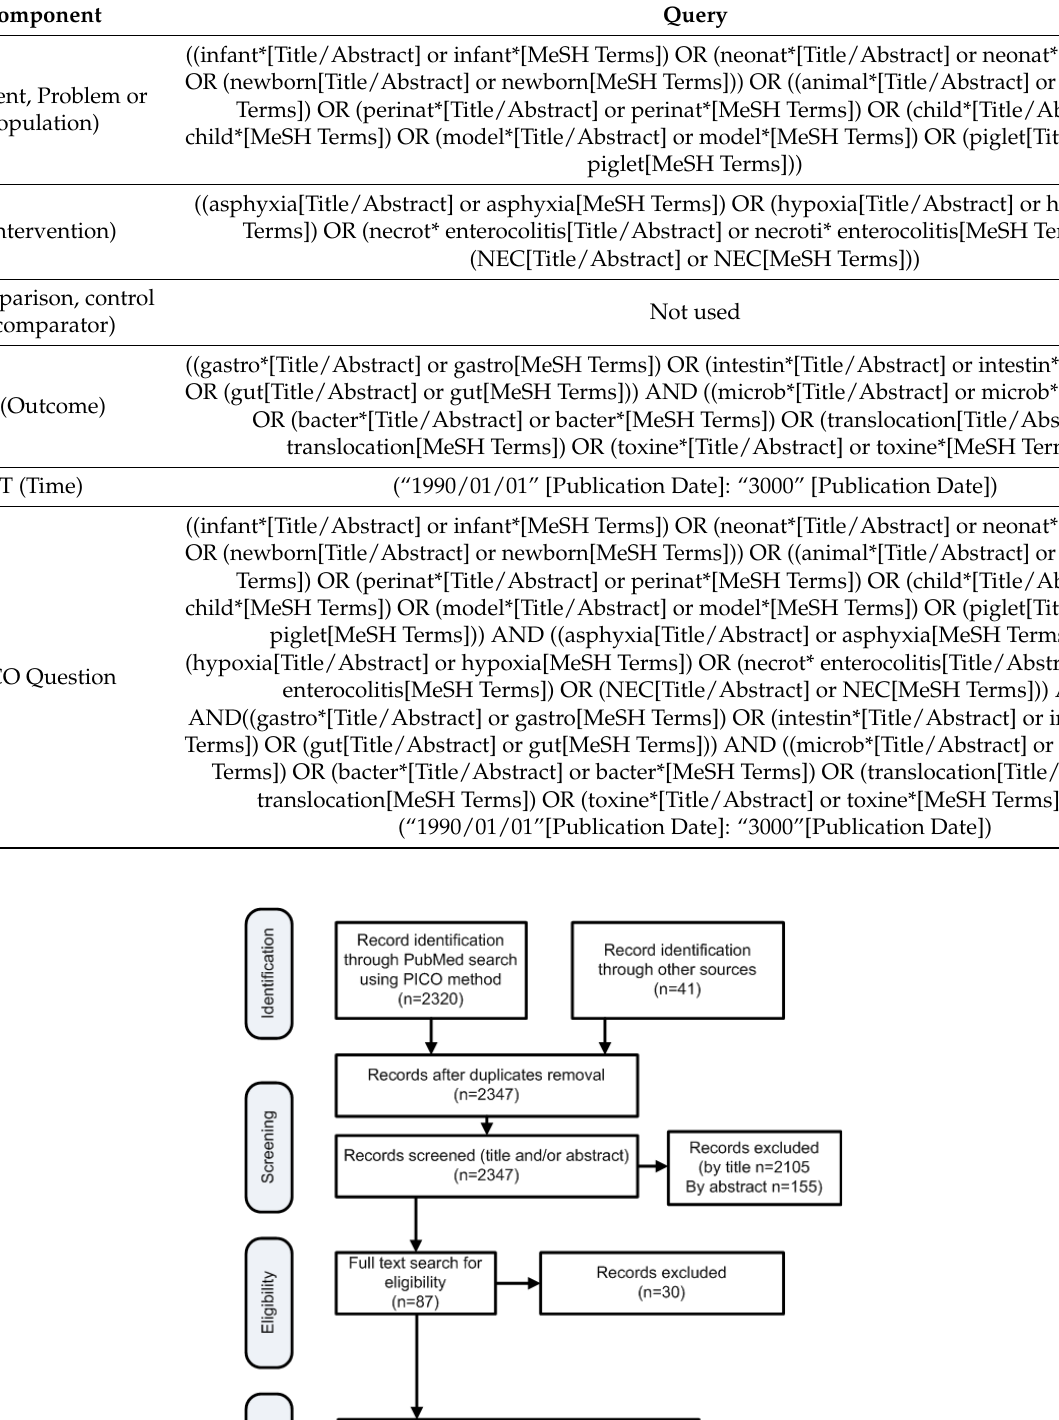
Table 1. Individual PICO Components.